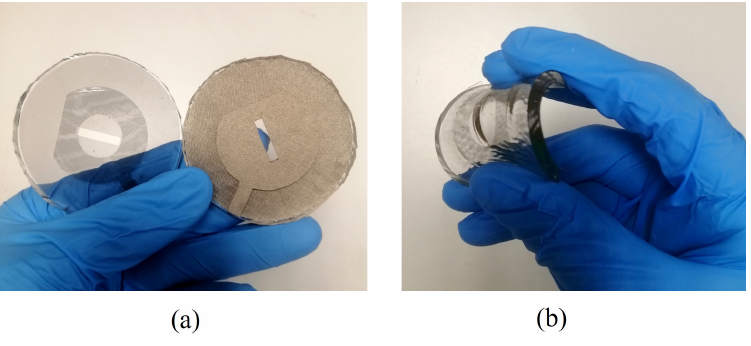
Figure 13. Fabricated prototypes: ( a ) transparent and non-transparent antenna prototypes, ( b ) transpar- ent antenna in bent